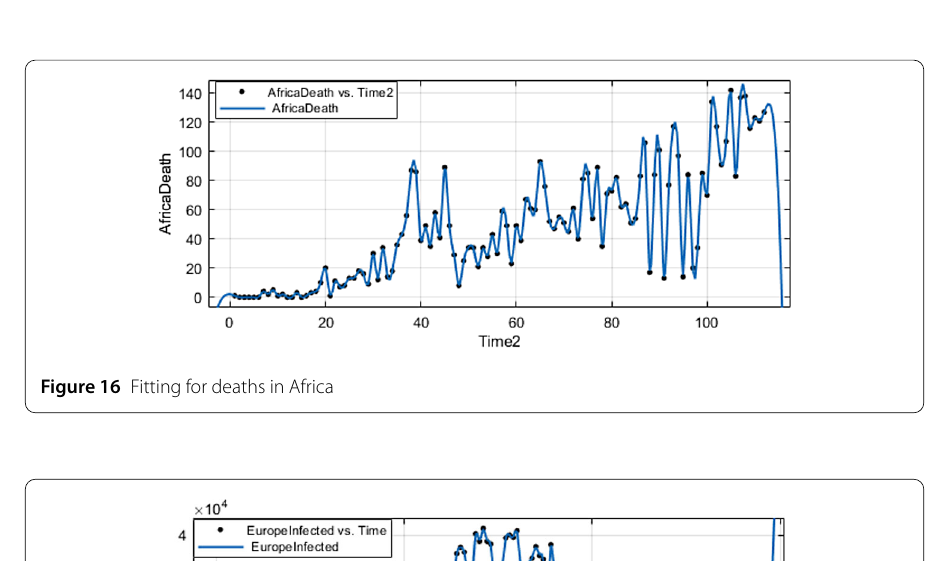
Figure 15 Fitting for the infected in Africa